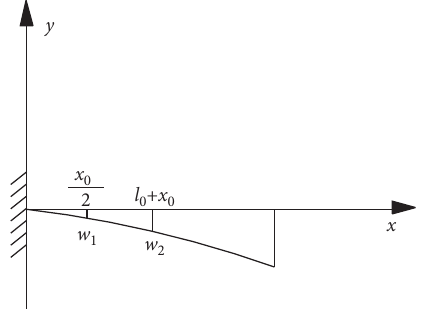
Figure 3: Flexural deflection of the cantilever